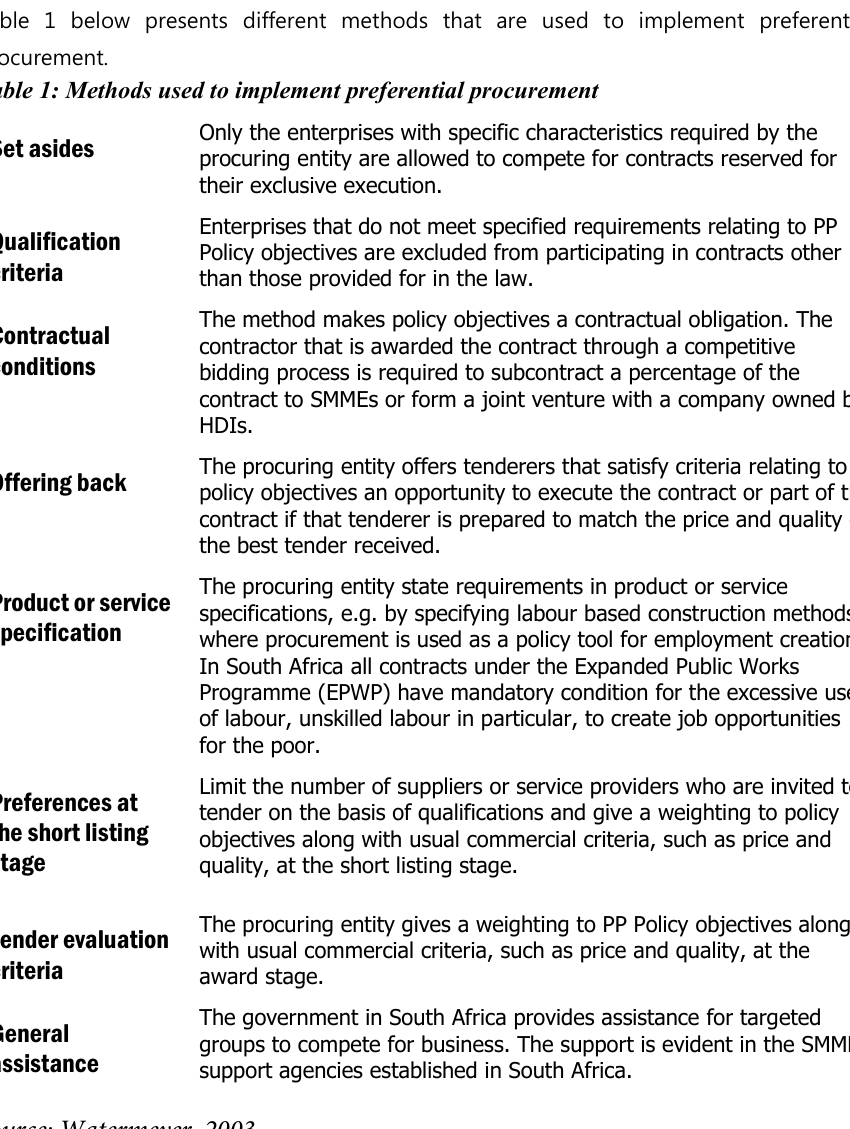
Table 1: Methods used to implement preferential procurement Set